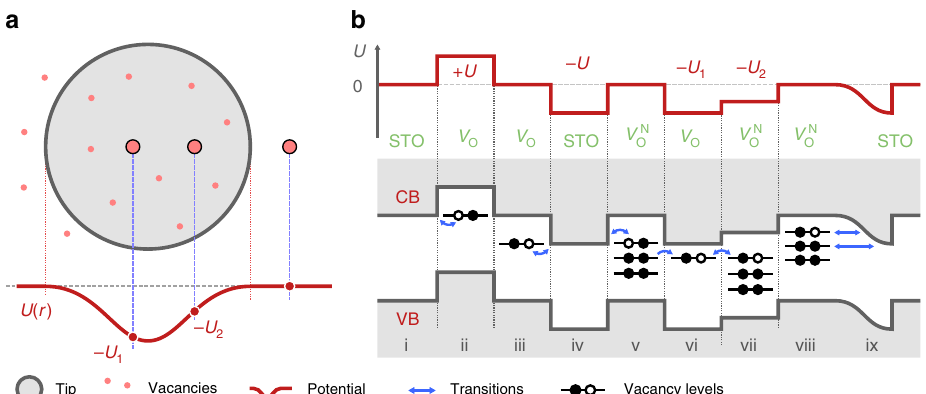
Fig. 5 Electronic transitions in oxygen vacancies caused by the potential of an oscillating AFM tip. a AFM tip, through electrostatic and van der Waals interactions, modi fi es the electron local potential at the surface in an area with one or several oxygen vacancies, altering their chemical potential (Fermi level) with respect to each other and the surrounding STO. Local alteration of chemical potential and electron level shifting can lead to a realignment of the impurity levels of V O facilitating electron transfer and provoking charge state transitions in the system. Several possible paths thereof are sketched in b where scenario (ii) and (iii) correspond to electron exchange between single vacancy and conduction band of SrTiO 3 , (v), (vi), (vii) — electron exchange between group of vacancies, and (viii), (ix) — electron exchange between vacancies and